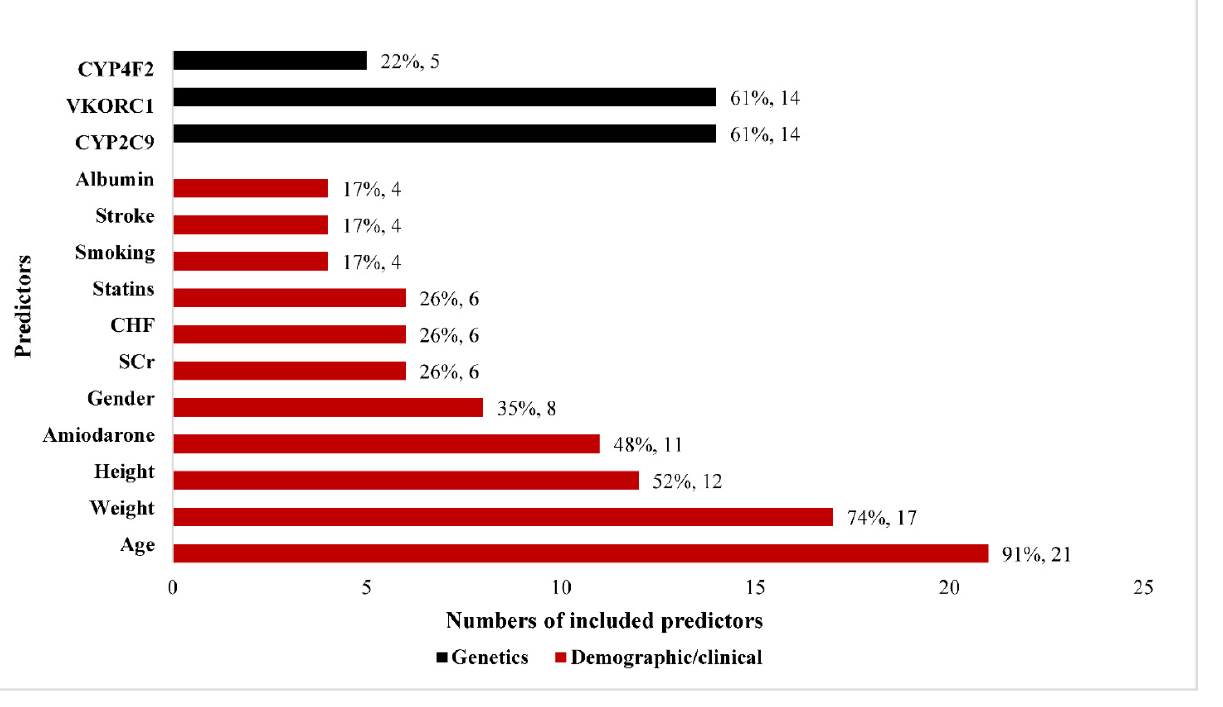
Figure 2. Predictors included at least 4 factors in all studies. SCr—serum creatinine; CHF—congestive heart failure.